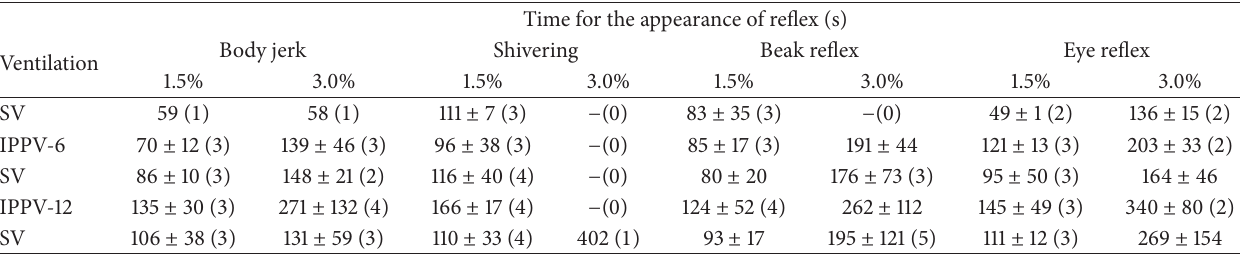
Numbers in parentheses indicate the number of birds in which the reflex was observed.